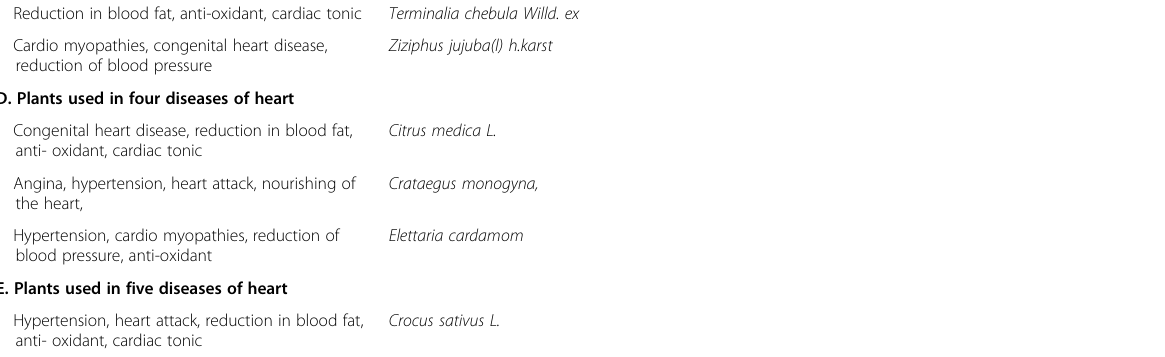
Table 2: Heart disease and the Plant Uses (A-C) (Continued) Reduction in blood fat, anti-oxidant, cardiac tonic